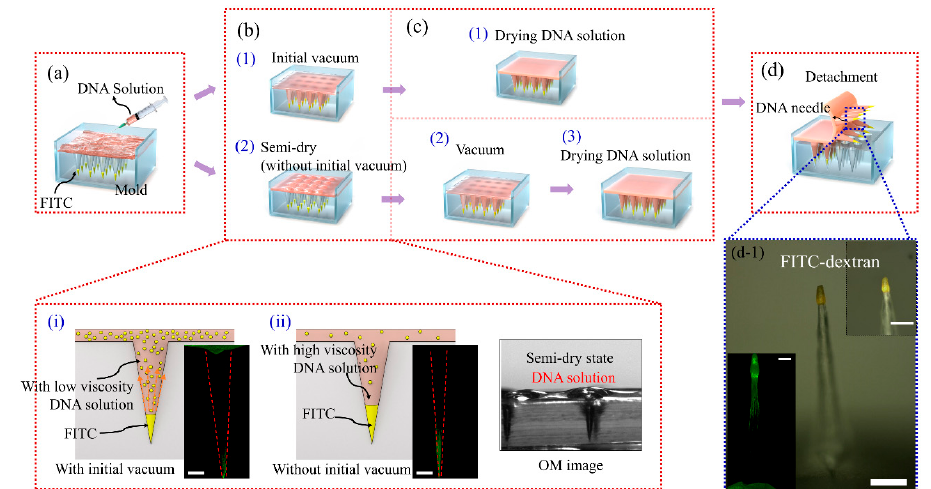
Figure 1. Fabrication process of FITC-loaded DNA microneedle with and without initial vacuum. ( a ) Loading of the 1% wt DNA solution into a mold loaded with FITC. ( b ) With / without initial vacuum step, (1) with initial vacuum, (2) without initial vacuum after pouring, and semi-drying. The enlarged image (i and ii) is the schematic diagram and pictures of the FITC-dextran di ff usion process in DNA solution during the needle manufacturing process and optical image of the semi-dry state in DNA solution (scale bar: 200 µ m). ( c ) (1) Drying DNA solution, (2) vacuum process, (3) drying DNA solution; ( d ) detachment (d-1) manufactured FITC-dextran-coated DNA microneedle (FITC: 100 mg / 10 mL). The inset indicates the enlarged needle and confocal microscopy image (scale bar: (i-ii) 100 µ m, (d-1) 200 µ